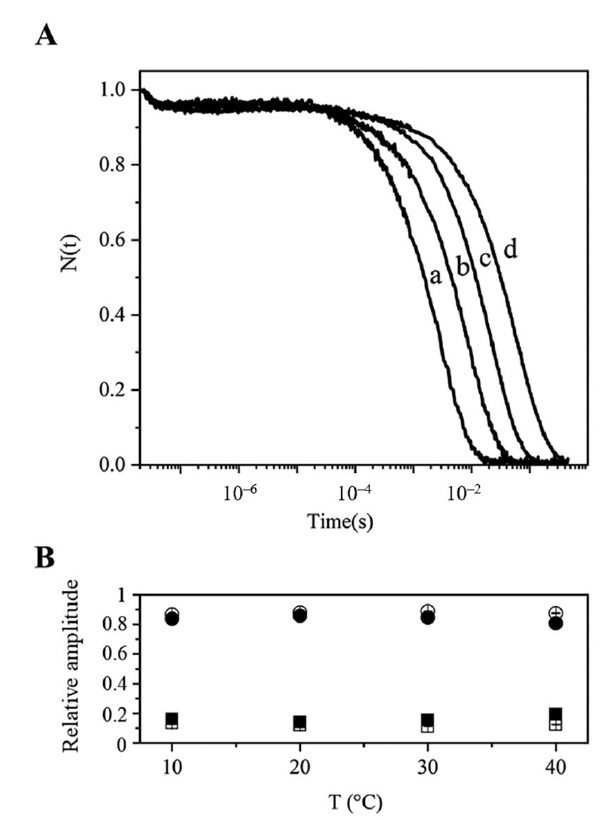
Figure 7. CO rebinding kinetics of Hs -Nb(II) after nanosecond laser photolysis at pH 7.4. ( A ) The progress curves of CO rebinding to Hs -Nb(II) (obtained at 436 nm, 10.0 °C (b, d) and 40.0 °C (a, c), and 0.2 CO atm (c, d) and 1.0 (a, b) CO atm) were normalized to the absorbance change at the end of the pulse. ( B ) Relative amplitudes of the two bimolecular kinetic phases for the Hs -Nb(II) (squares: fast reaction; circles: slow reaction; open symbols, 0.2 CO atm, filled symbols, 1.0 CO atm).